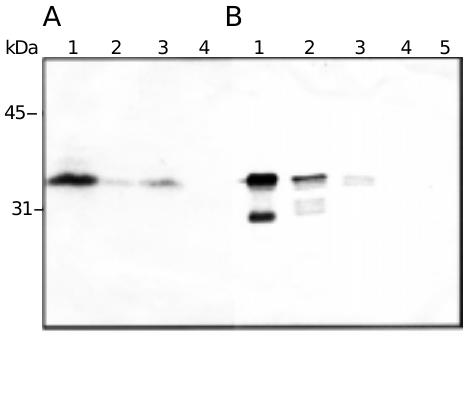
Figure 3 - A, Recognition of M. smegmatis -expressed P36 by cattle sera. Western blot was performed using the culture su- pernatant from M. smegmatis (pMBA61). Sera from infected (lanes 1-3) or healthy (lanes 4 and 5) cattle were used. B , Rec- ognition of P36 expressed in insect cells (3 days post-infec- tion) by cattle sera. Western blot was performed using the culture supernatant from insect cells infected with recombinant baculoviruses. Sera from healthy (lanes 1-3) or infected (lanes 4-6) cattle were